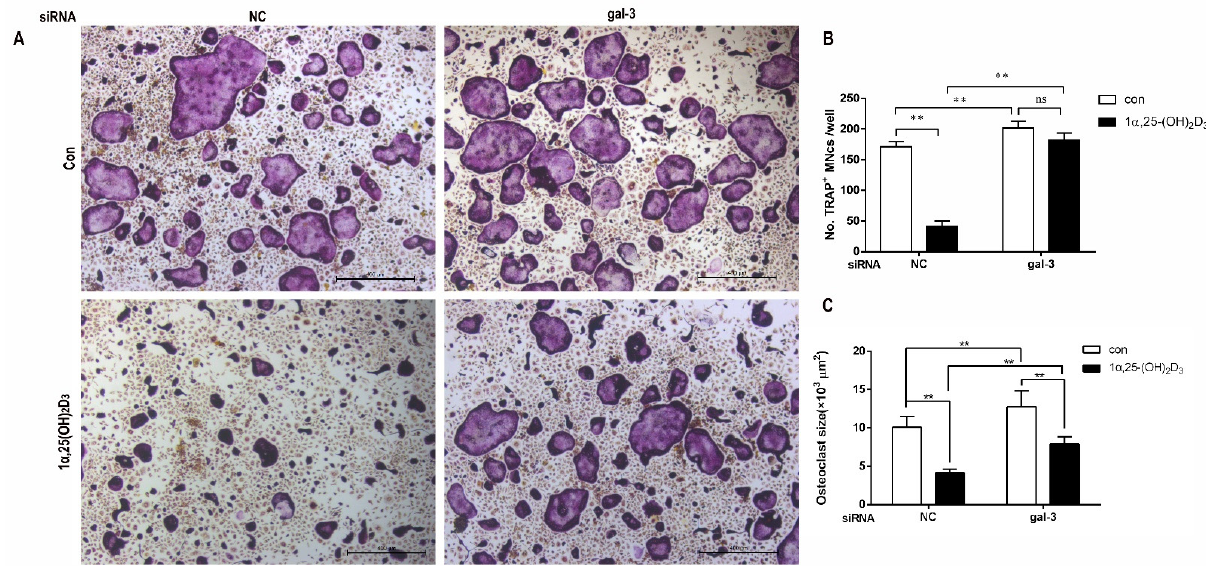
Figure 6. Gal-3 knockdown attenuated the inhibitory effect of 1 α ,25-(OH) 2 D 3 on OC formation. ( A ) TRAP staining. Large multinuclear cells (MNCs) with wine-red granules were regarded as OCs (yellow arrows). Bars = 400 μ m. ( B ) Quantitative analysis of OC quantity. ( C ) Quantitative analysis of OC size. Data are shown as means ± SD. n = 3, ** p < 0.01, ns means p > 0.05.